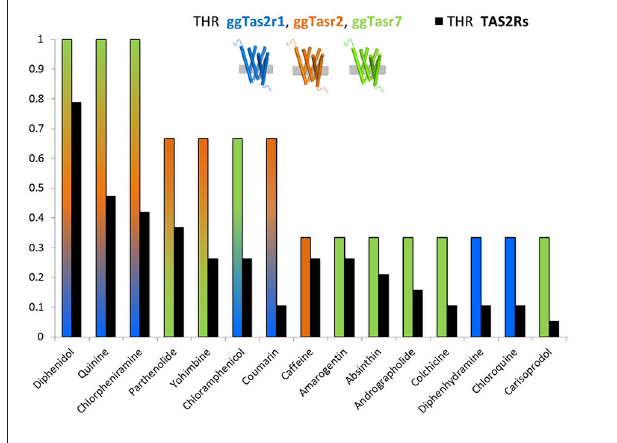
FIGURE 1 | THR (target hit-rate) of bitter compounds toward human TAS2Rs (black bars) and chicken ggTas2r1, ggTas2r2, ggTas2r7 (blue, orange, and green bars, respectively). THR parameter is the number of targets hit at a specific concentration divided by the number of targets tested (Azzaoui et al., 2007; Di Pizio and Niv, 2015). Specifically, only compounds that elicited receptor activation of both human TAS2Rs and ggTas2rs at concentration of 300 µ M or lower were used to generate this